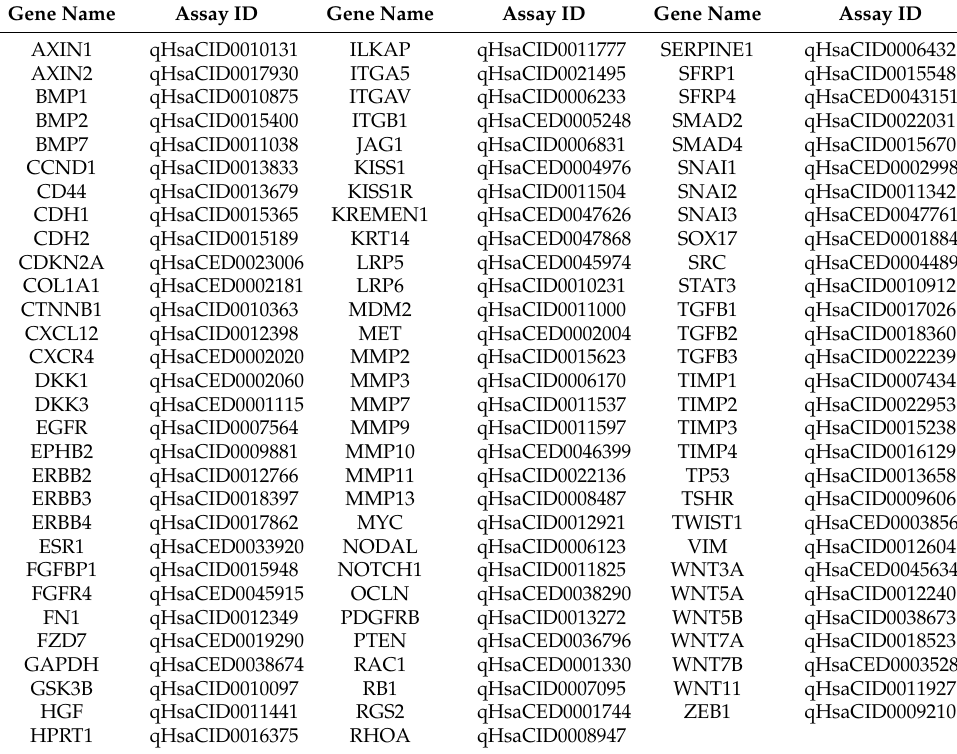
Table 3. List of cancer stem cell- and metastasis-related